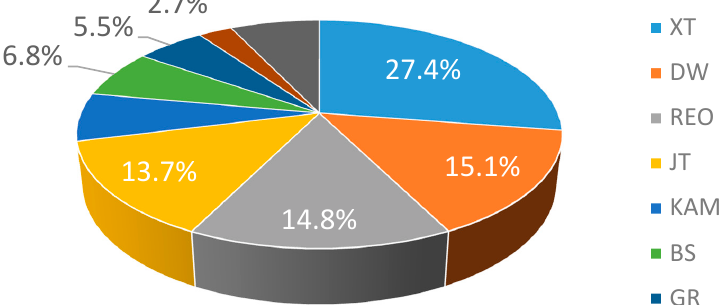
Figure 26. Market shares of MH alloys produced in China in 2016. XT: Xiamen Tungsten, DW: Doublewin, REO: Rare-earth Ovonic, JT: Jiangxi Tungsten, KAM: Kingpowers Advanced Materials,